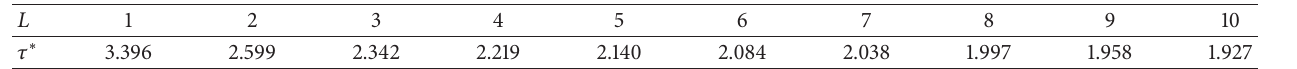
Table 1: Admissible dwell time with different 𝐿